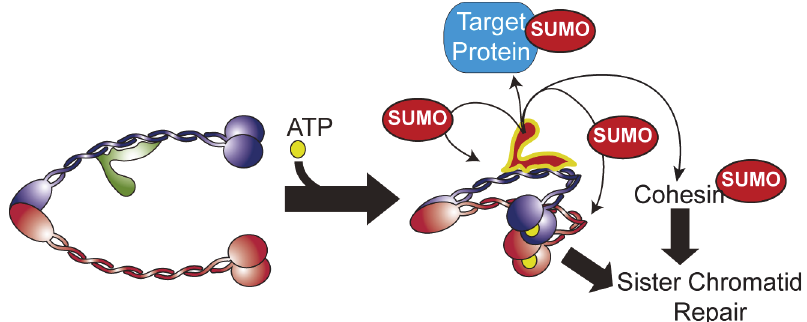
Fig 9. Model for the ATPase-dependent regulation of the SUMO ligase activity in the Smc5/6-Mms21 complex. Binding of ATP to the ATPase heads of Smc5/6 induces a conformational change that activates the Mms21 SUMO ligase; the structural maintenance of chromosomes (SMC) role of the Smc5/6 complex and the Mms21-dependent sumoylation of targets, such as cohesin, collaborate in homologous recombinational repair and chromosome